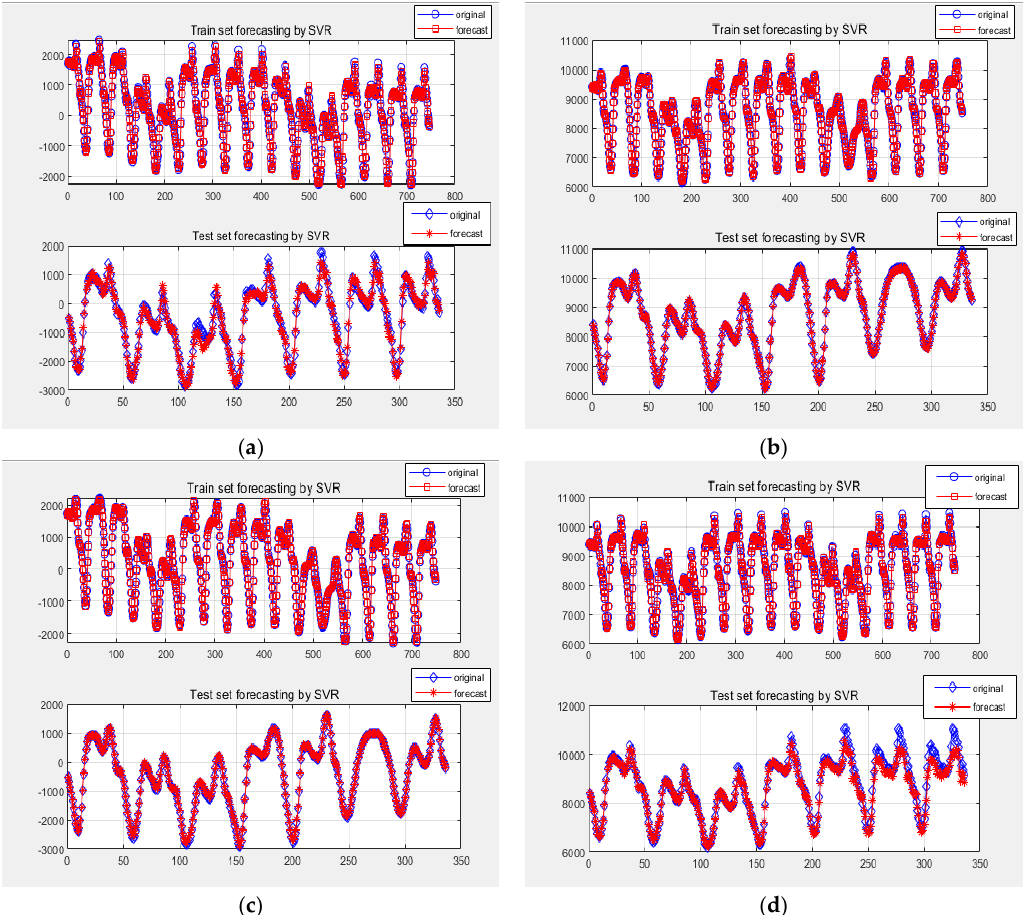
Figure 5. Comparison the forecasting results for different defined items by the SVR-PSO model (the large sample; one-week ahead forecasting on 18 to 24 May 2007). ( a ) Item A: the random term + the middle term; ( b ) Item B: the middle term + the trend (residual) term; ( c ) Item C: the middle term; ( d ) Item D: A + B − C (all IMFs, i.e., complete decomposed effects).